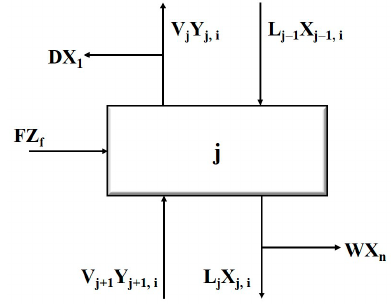
Figure 3. Model diagram of a single tray.